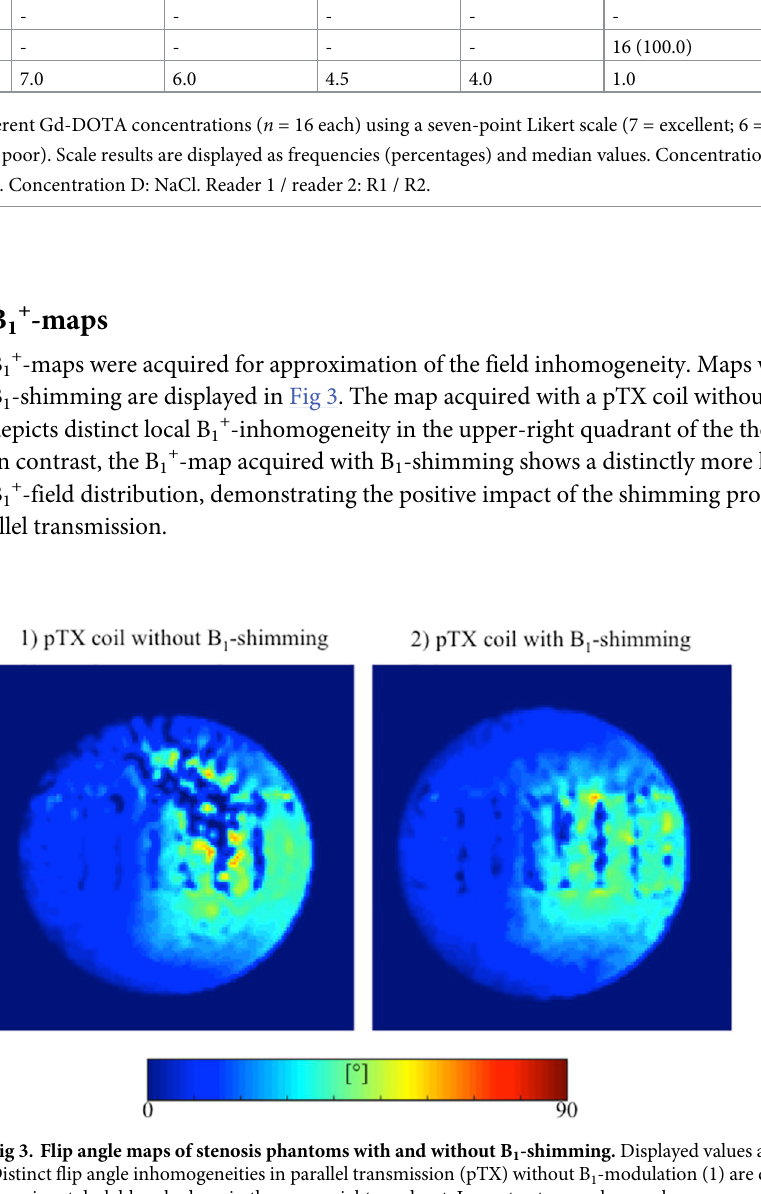
Fig 3. Flip angle maps of stenosis phantoms with and without B 1 -shimming. Displayed values are limited to 90˚. Distinct flip angle inhomogeneities in parallel transmission (pTX) without B 1 -modulation (1) are displayed as prominent dark blue shadows in the upper-right quadrant. In contrast, a much more homogenous flip angle distribution was observed using pTX with automated B 1 -shimming (2).